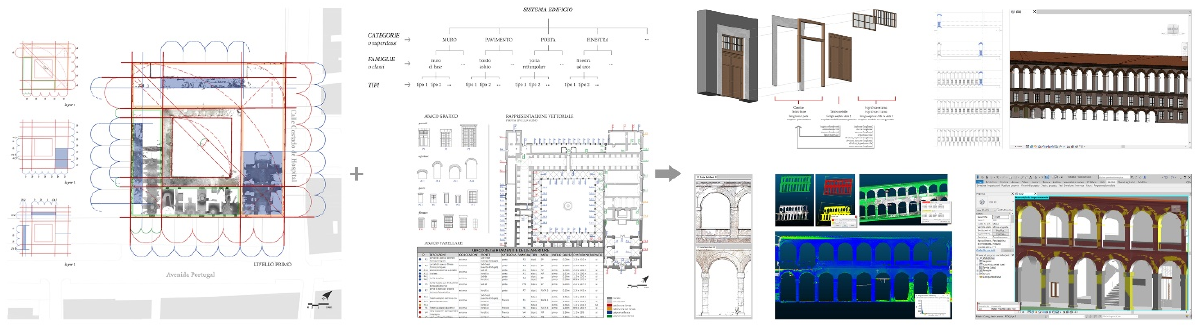
Figure 5: Synthesis of the modelling process of the Simón Ruiz